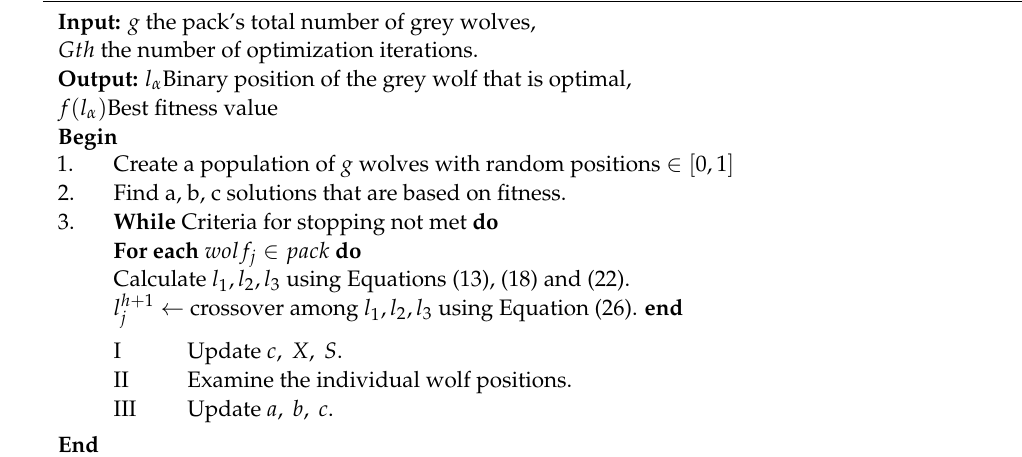
Algorithm 1. Reformed Features Optimization